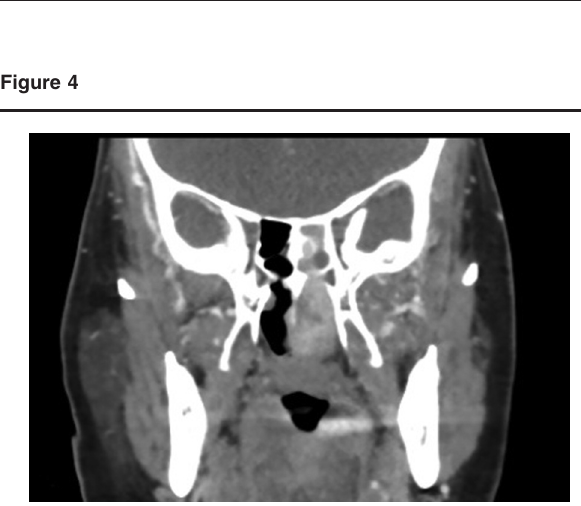
The tumor extends into the nasopharynx and reach the right posterior choana.